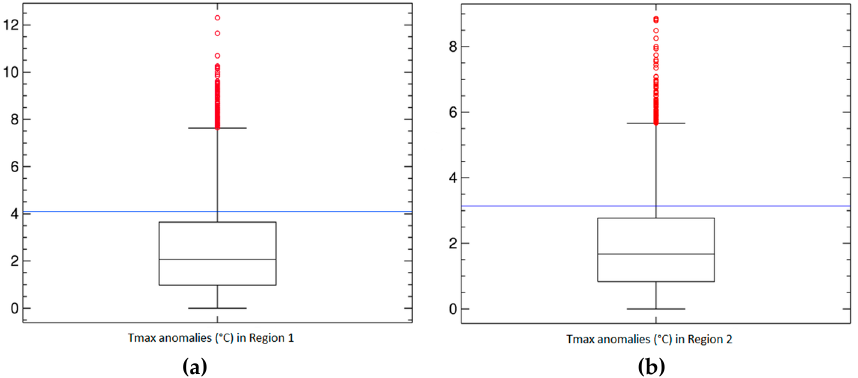
Figure 3. Box plot of the distribution of the daily maximum temperature (Tmax) anomalies (°C) in regions ( a ) 1 and ( b ) 2. The horizontal blue line represents the 90% percentile of these anomalies and the red circles represent the extreme values.